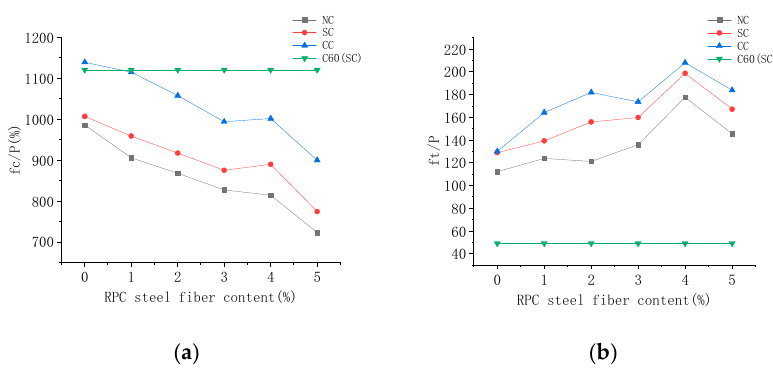
Figure 15 . Cost performance analysis of steel fiber-reinforced active powder concrete and C60: ( a ) Compression strength cost performance comparison; ( b ) splitting tensile strength cost performance comparison.